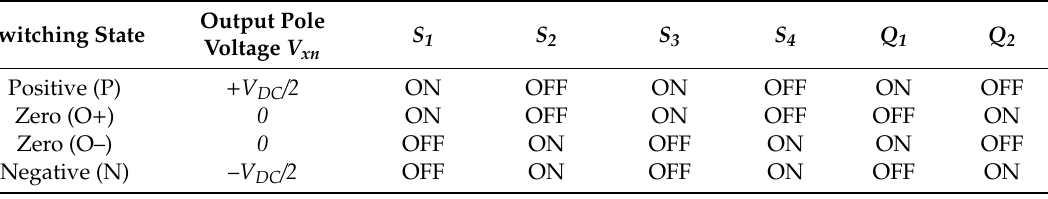
Table 1. Switching states based on the switch status of the HANPC inverter.